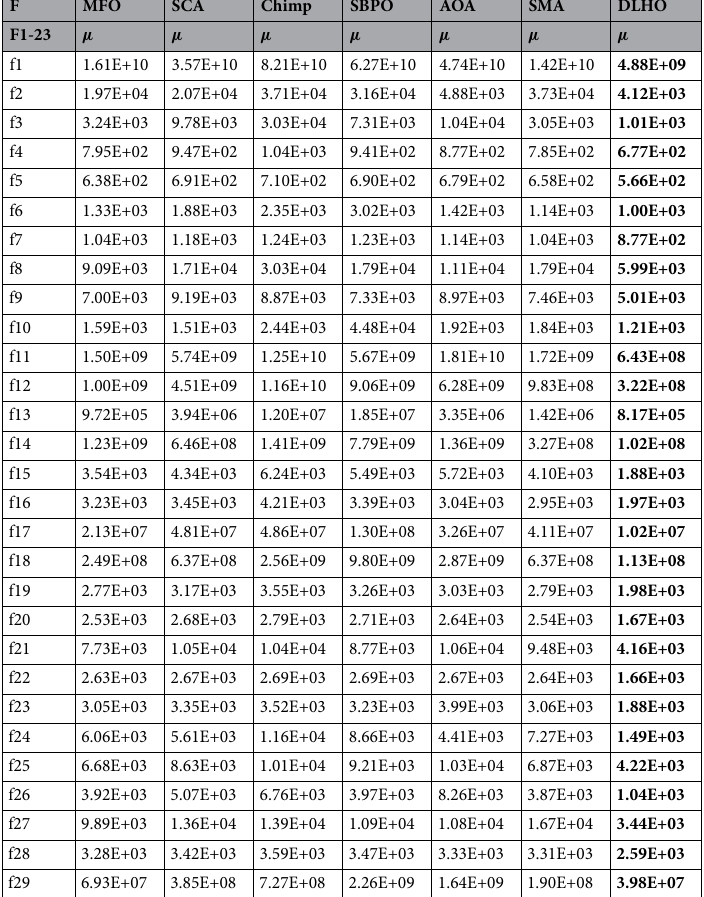
Table 5. Mean ( µ ) outcomes of Optimizers on the 29-CEC-2017